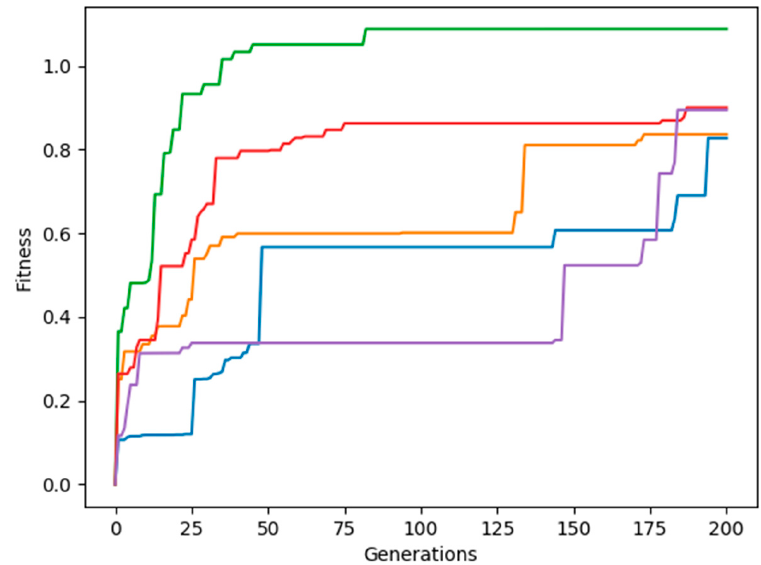
Figure 8. Diagonal joint reverse symmetry fitness for 5 simulation runs.